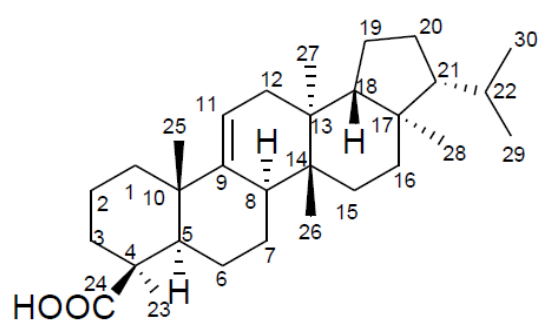
Figure 1. The structure of davallic acid.